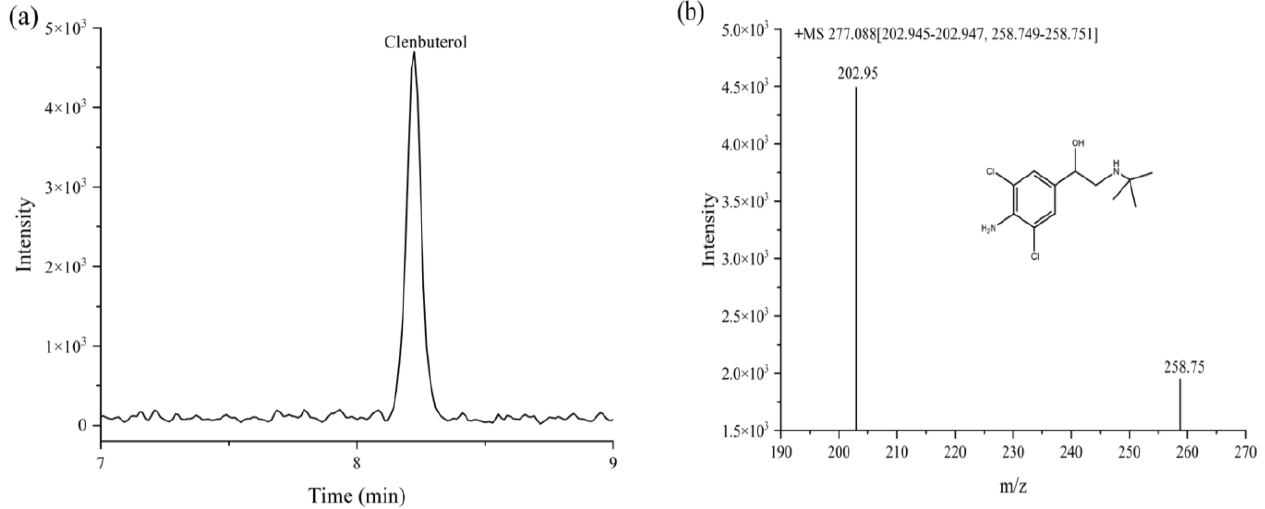
Figure 5. Chromatogram ( a ) and mass spectrogram ( b ) of CLB in the positive sample.